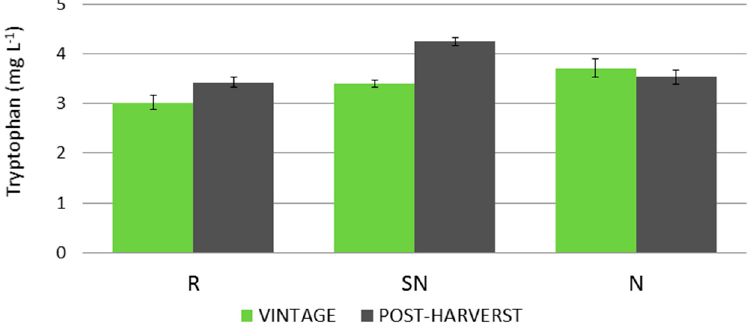
Figure 3. Evolution of tryptophan levels during the post-harvest period for three different cultural